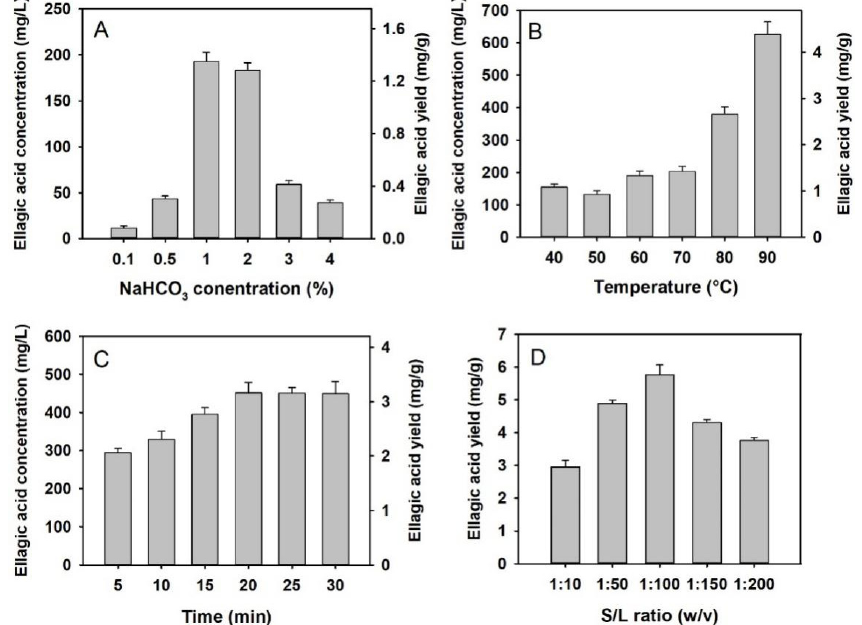
Figure 3. Single factor assays of the extraction method with sodium bicarbonate assistance. ( A ) factor of NaHCO 3 concentration; ( B ) factor of extraction temperature; ( C ) factor of extraction time; ( D ) factor of S/L ratio. Data are represented as mean + standard deviation ( n = 3).